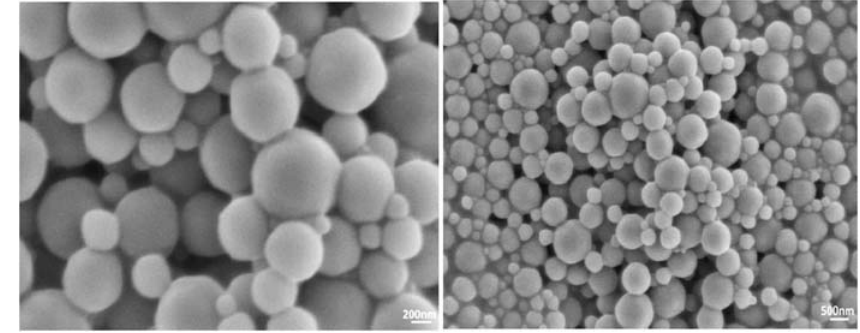
Figure 4: SEM images of PDAA at di ff erent magni fi cation.